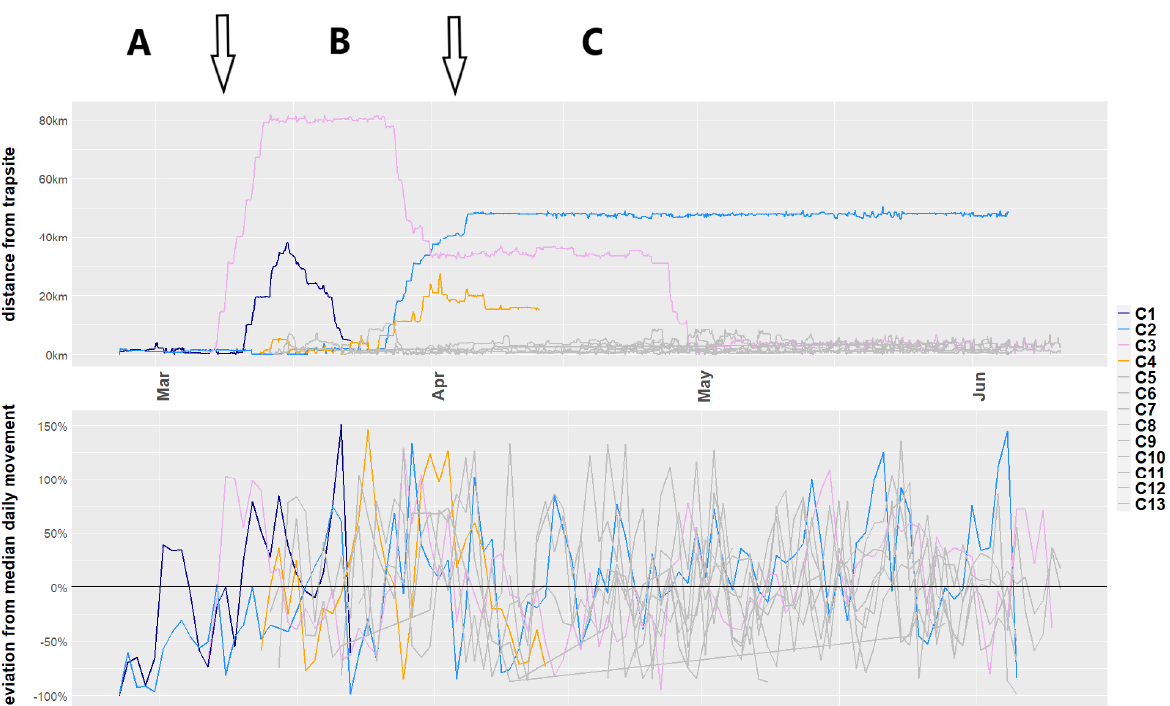
Figure 2. Movement summary over time (February to June 2020) of the feral cats captured in the IFRNP (Dark Blue = Cat 1; Light blue = Cat 2; Purple = Cat 3; Orange = Cat 4). Arrows indicating change in movement behaviour between sedentary (A and C) and long-distance movements (B).